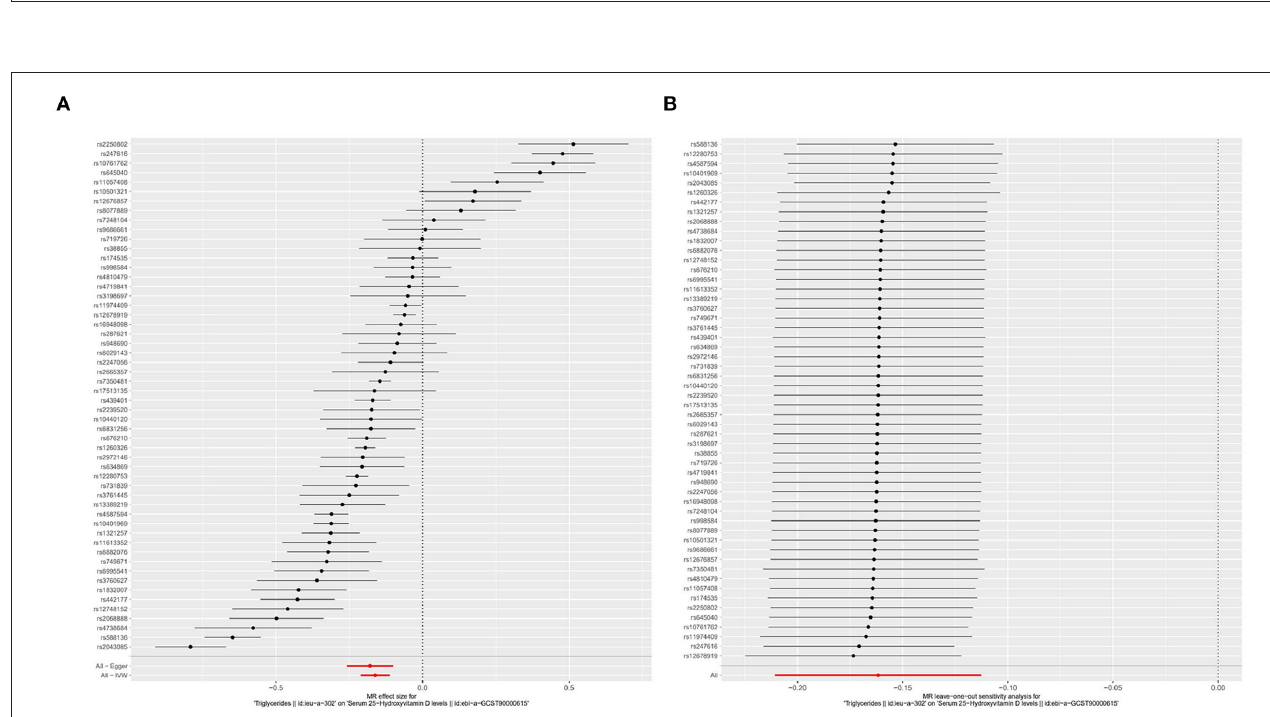
FIGURE 2 | Forest plot of included SNPs in the mendelian randomization analysis for casual effect of triglycerides on vitamin D deficiency. (A) Meta-analysis of SNPs’ effects on vitamin D deficiency based on inverse variance weighted (IVW) method with random effect model. (B) Sensitivity analysis by omitting every SNP.